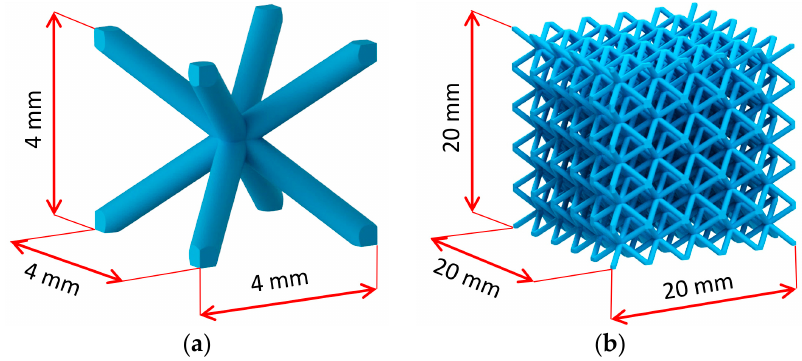
Figure 2. ( a ) BCC unit cell; ( b ) BCC lattice structure sample.